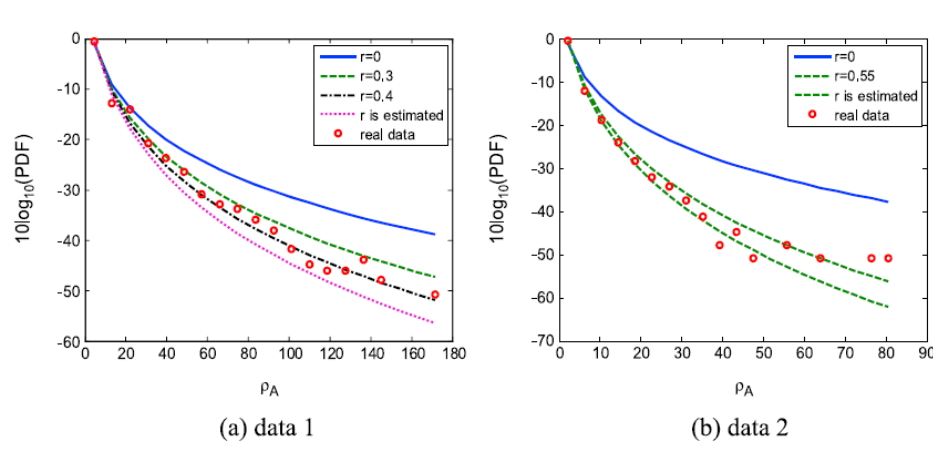
Fig. 8 Simulation results of K-distributed